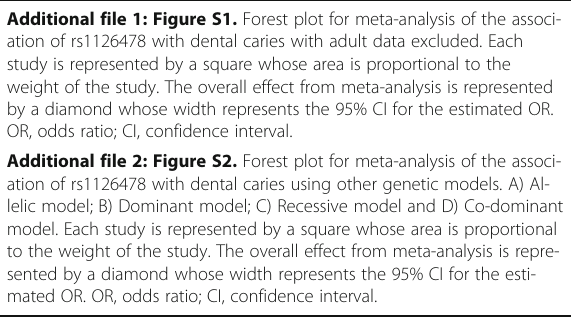
Additional file 1: Figure S1. Forest plot for meta-analysis of the associ- ation of rs1126478 with dental caries with adult data excluded. Each study is represented by a square whose area is proportional to the weight of the study. The overall effect from meta-analysis is represented by a diamond whose width represents the 95% CI for the estimated OR. OR, odds ratio; CI, confidence interval. Additional file 2: Figure S2. Forest plot for meta-analysis of the associ- ation of rs1126478 with dental caries using other genetic models. A) Al- lelic model; B) Dominant model; C) Recessive model and D) Co-dominant model. Each study is represented by a square whose area is proportional to the weight of the study. The overall effect from meta-analysis is repre- sented by a diamond whose width represents the 95% CI for the esti- mated OR. OR, odds ratio; CI, confidence